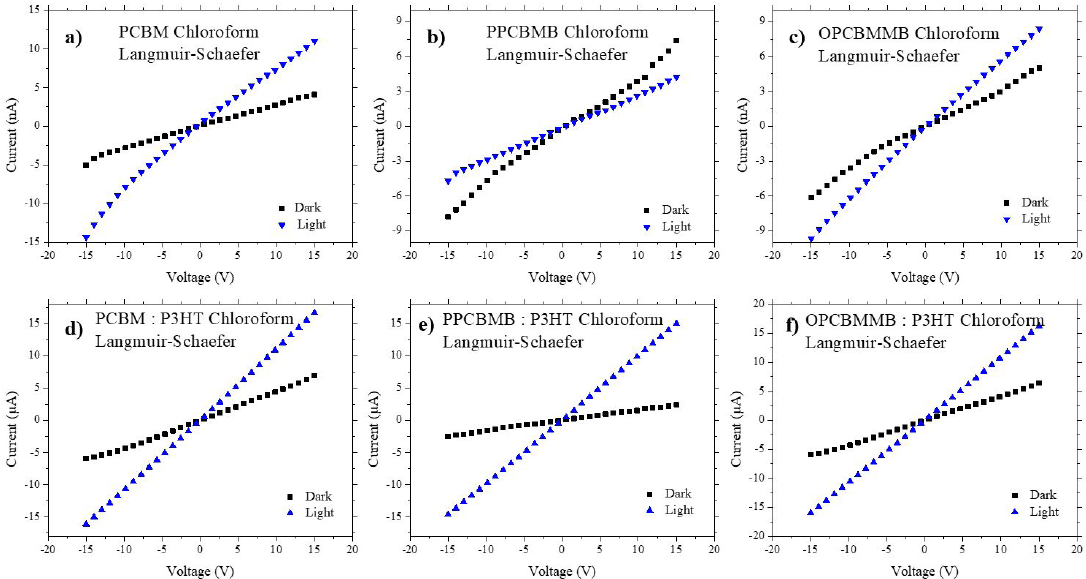
Figure 5. I vs V curves for pure and mixed films with poly(fullerene)s and P3HT, produced by the LS technique solubilized with